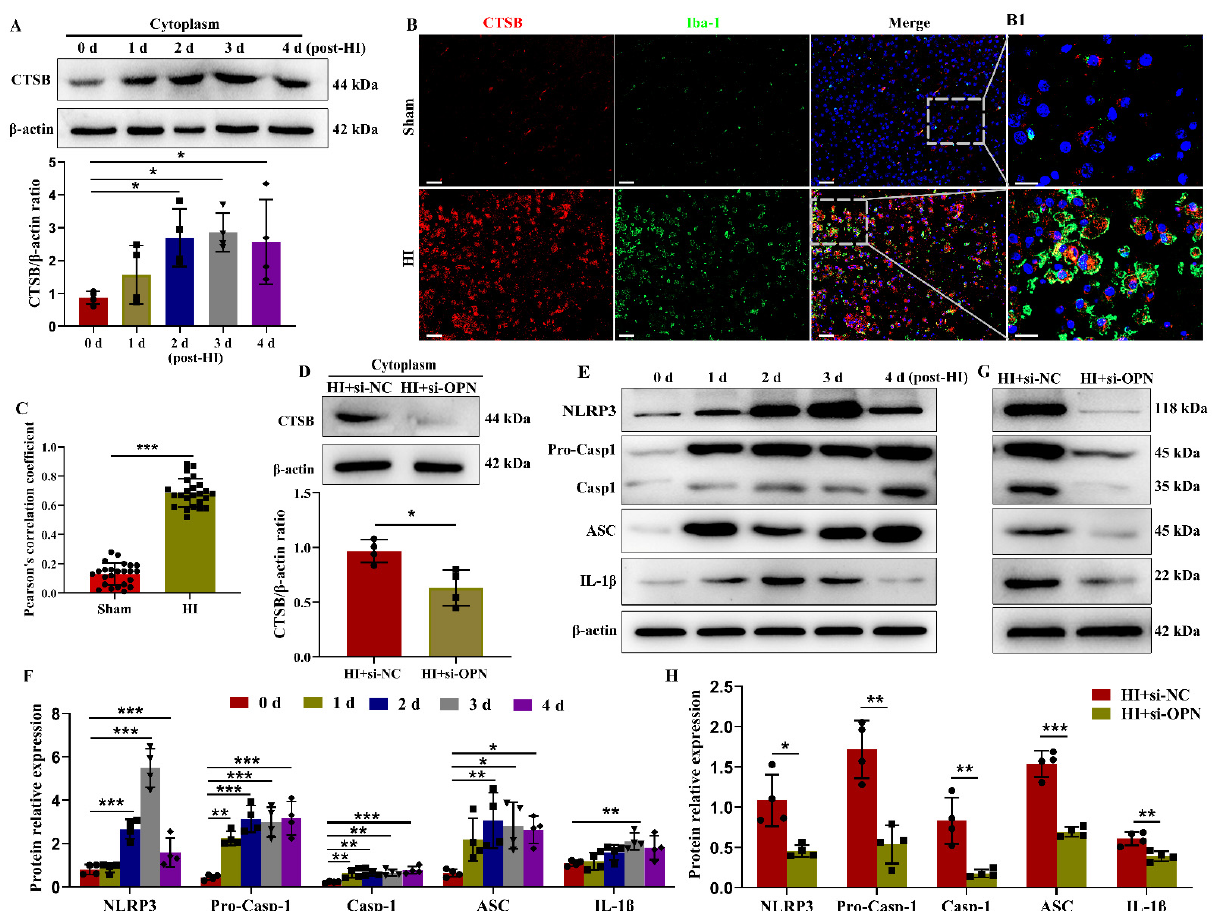
Figure 4 . Silencing of OPN repressed HI-induced CTSB releasing and NLRP3 inflammasome acti- vation. ( A ) The expression of CTSB protein in the cytoplasm of the ipsilateral cortex was measured by Western blot at 0 d, 1 d, 2 d, 3 d, and 4 d after HI ( n = 4). All experiments were performed three times. ( B,C ) Immunofluorescence images and quantitative measurement revealed colocalization